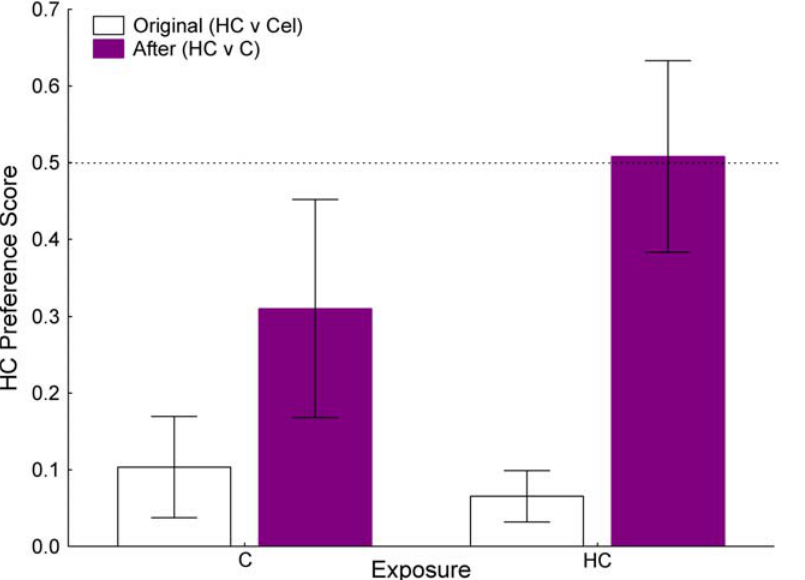
Figure 9. Mean (SE) guinea pig preference scores for HC v Cel (open bars) and for HC v C (purple bars). Individuals (N=8) that were exposed to C between the two preference tests are shown on the left side of the figure; individuals (N=8) that were exposed to HC between the two preference tests are shown on the right side of the figure. Regardless of exposure type, HC preference scores increased following exposure sessions (see text for